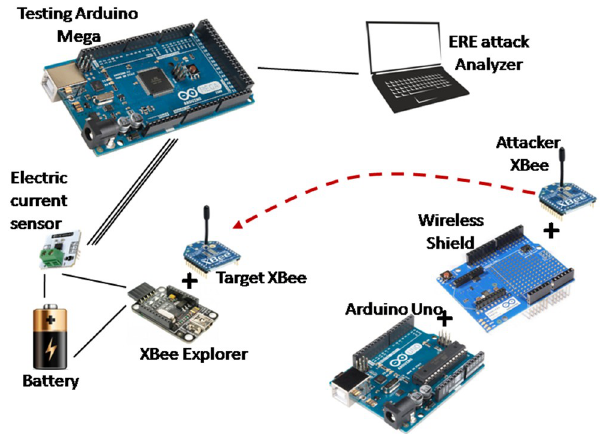
Figure 4. Diagram of the test bed for simulating ERE attack on XBee.